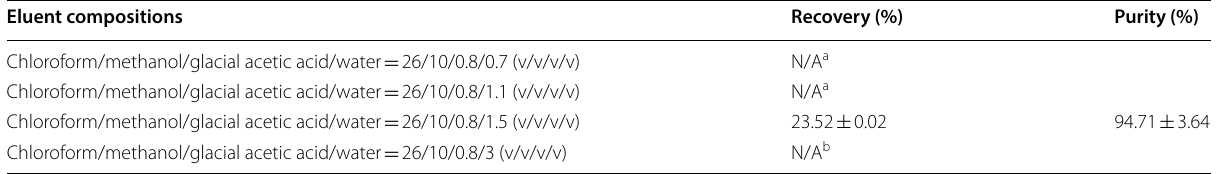
a N/A, not available. Owing to the low polarity of the eluent, PMA could not be eluted b N/A, not available. Because separation of PMA from the impurities and PC was not achieved Table 2 Different gradient eluent conditions (quantitative analysis by HPLC, flow rate Gradient eluent system